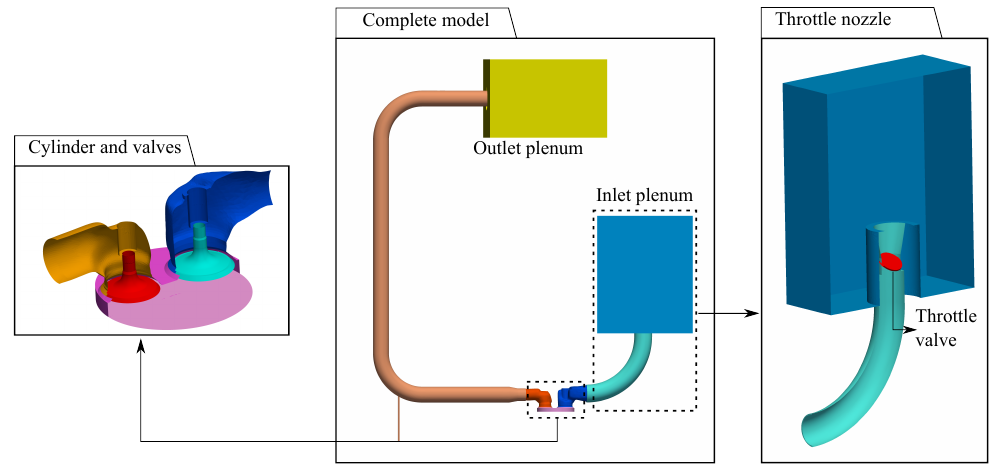
Figure 4. Description of the main parts of the computational domain.